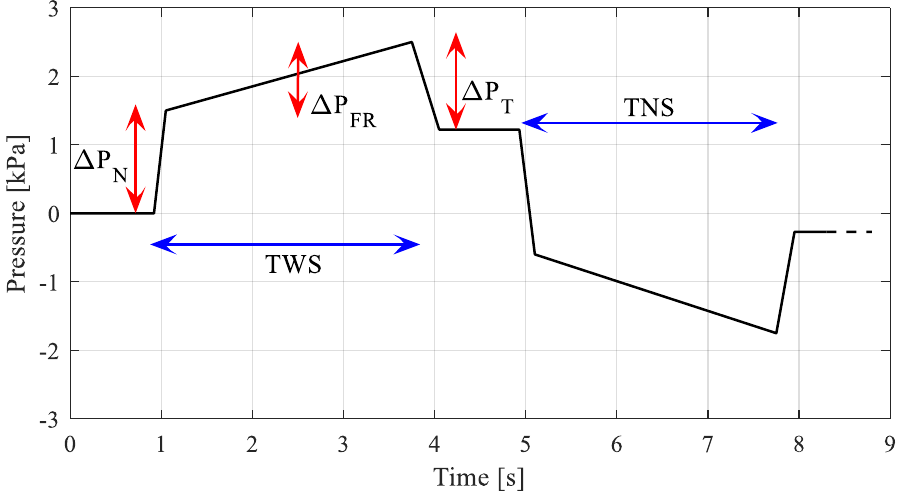
Figure 2. Schematic representation of TWS (Train Wave Signature) and TNS (Train Near-field Signature) measured by the sensor of Figure 1.